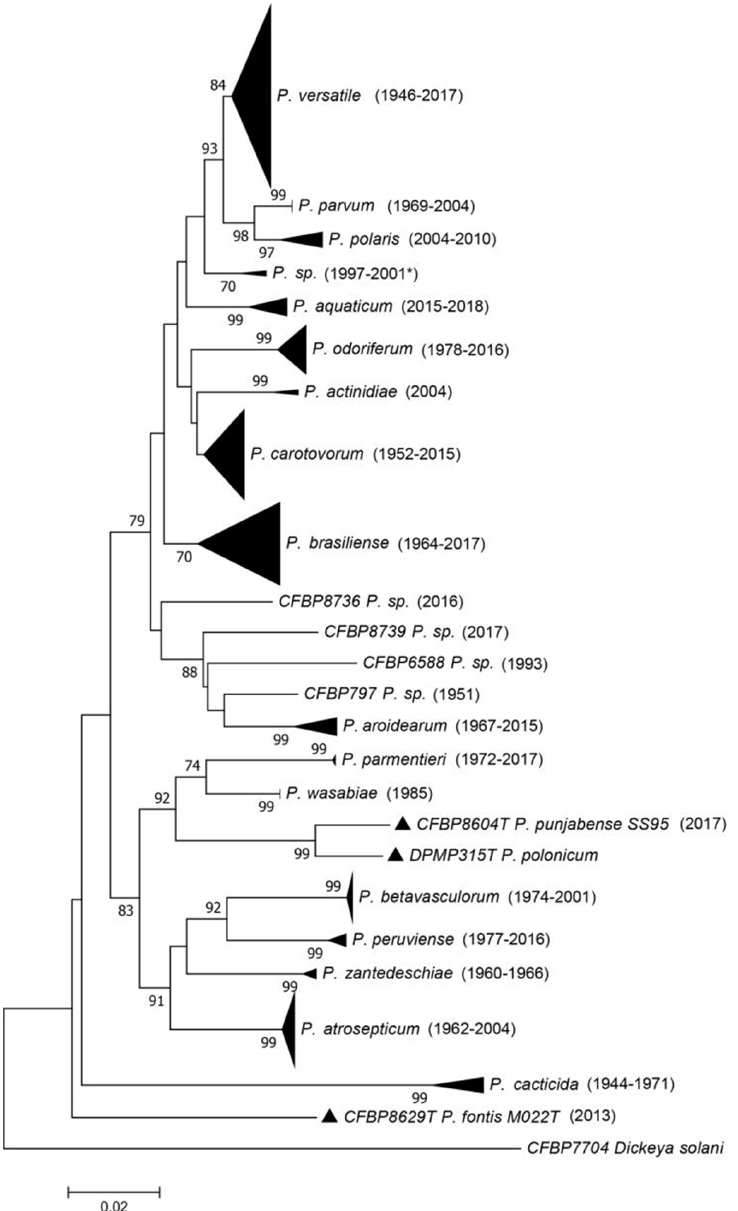
Figure 1. Phylogenetic tree reconstructed from concatenated partial sequences from dnaX , leuS and recA housekeeping genes. The phylogenetic tree was reconstructed with concatenated alignments of all genes with MEGA 7.0.26 using the neighbor-joining method with 1000 bootstrap replicates, and the evolutionary distances were computed using the Kimura two-parameter method. Bootstrap values are shown when over 70. The earliest and latest isolation years for each species are shown in parentheses. When there is only one strain in the clade, the year of isolation for that strain is indicated. For one clade, the latest year of isolation is unknown, and the latest year of deposit is indicated as follows: 2001*. Source: Portier et al.